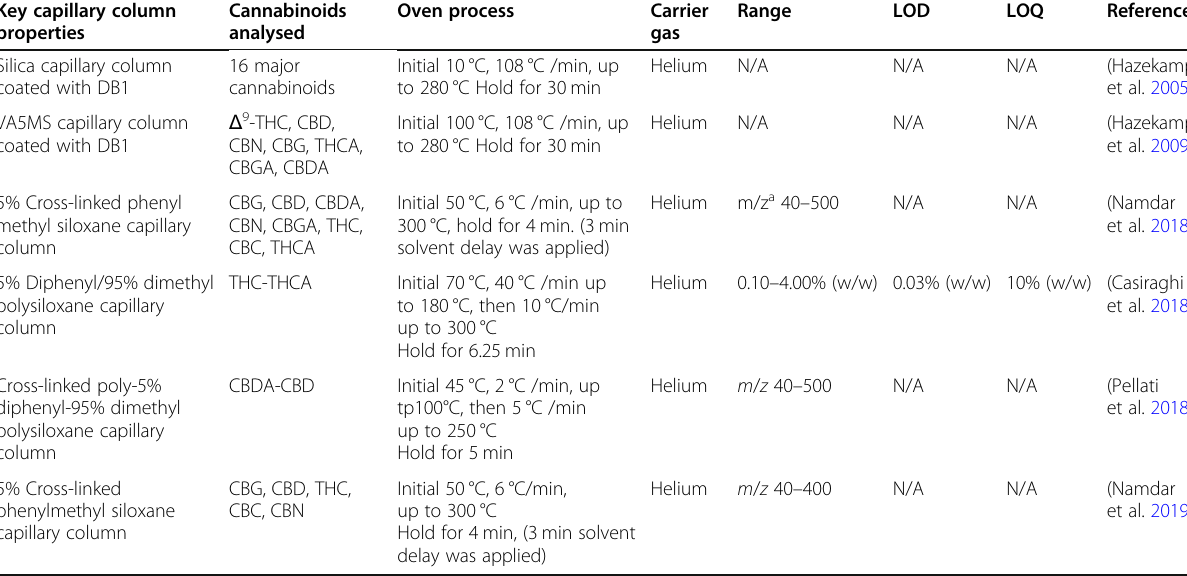
Table 1 An overview to the key properties of common GC-MS method for analysing cannabinoids with a capillary column in six different